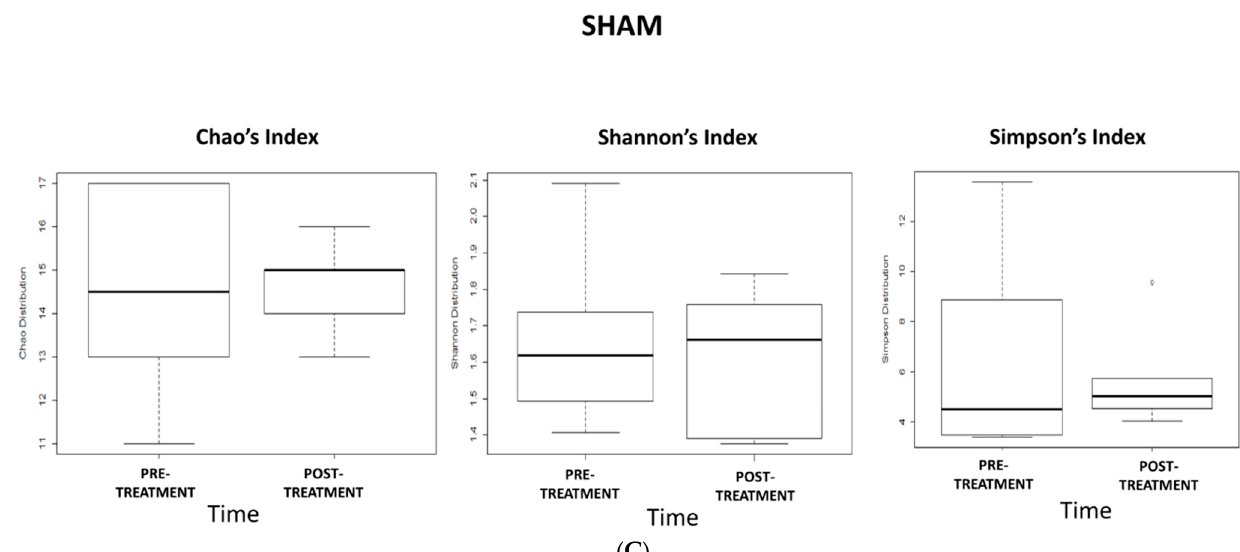
Figure 3. Effects of 5-week dTMS treatment on gut microbiota biodiversity evaluated by Chao’s, Shannon’s, and Simpson’s indices in the 3 treatment groups: ( A ) HF, ( B ) LF, ( C ) sham.